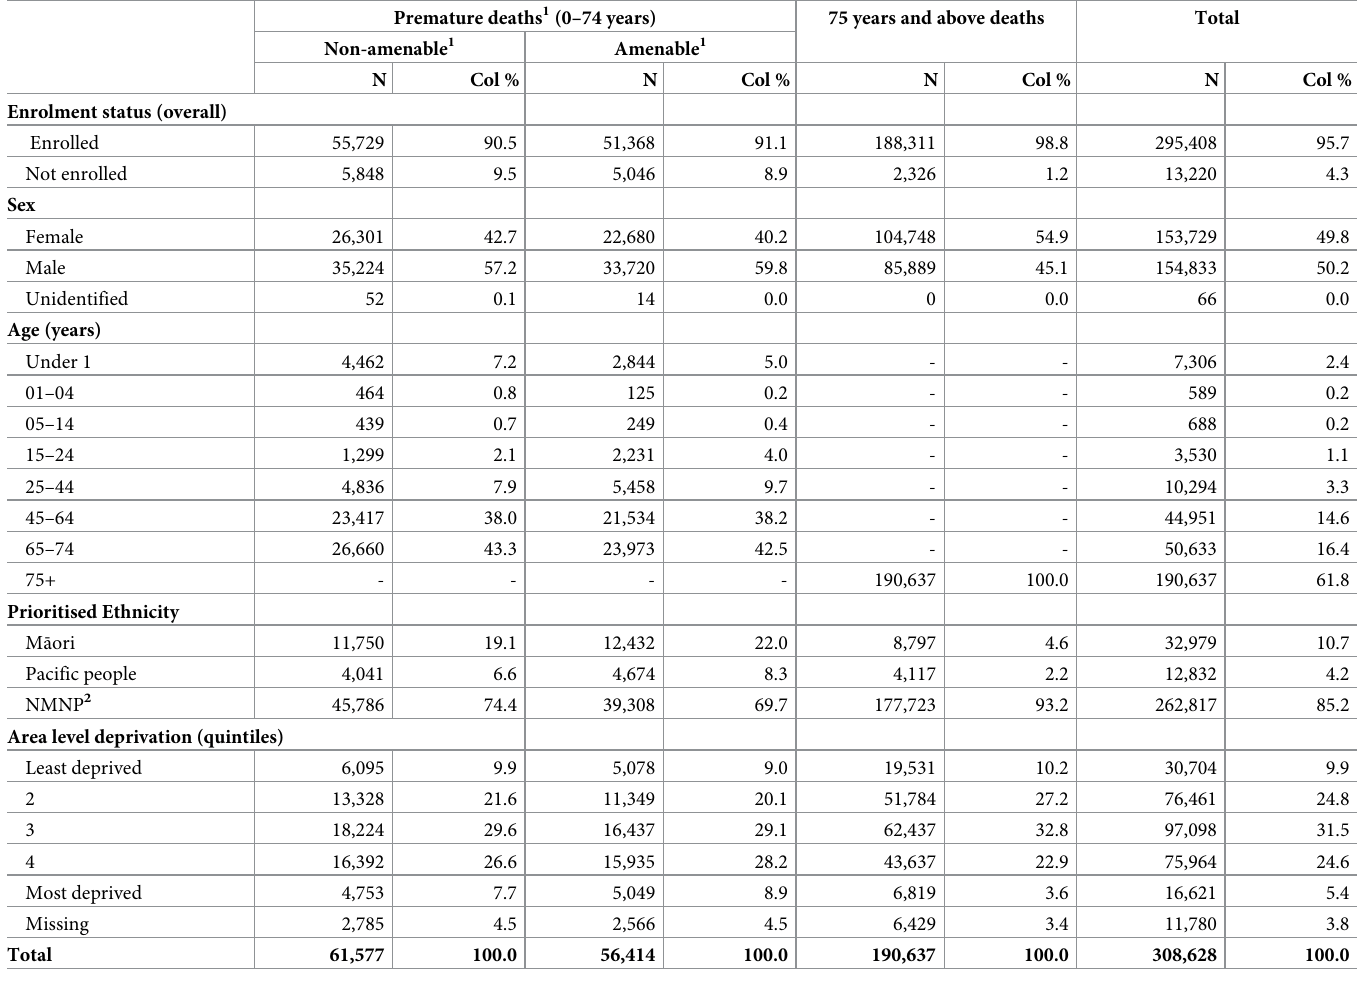
Table 1. Socio-demographic characteristics of the study population by premature and amenable death